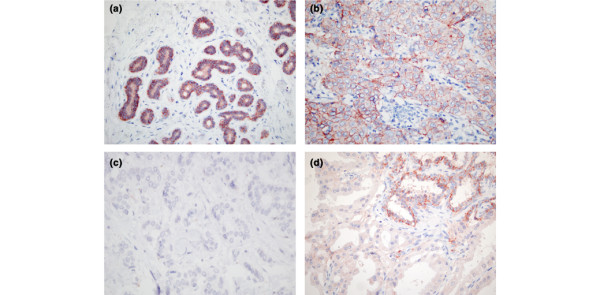
Claudin (CLDN)4 expression in benign breast epithelium, in invasive ductal carcinomas and in intraductal papilloma. (a) Intense CLDN4 positivity in benign breast epithelium. Shown is the immunohistochemical reaction of benign breast using monoclonal CLDN4 antibody (Zymed). Strong positivity is seen in epithelial cell membranes. Sections were counter-stained with Mayer's haemalaun. The chromogen substrate was aminoethylcarbazol. (Original magnification: 400×.) (b) CLDN4 positivity in invasive ductal breast carcinoma. CLDN4 is expressed in invasive ductal breast carcinoma of grade 3. Positive reaction is evident in the membranes of the tumour cells. Sections were counter-stained with Mayer's haemalaun. The chromogen substrate was aminoethylcarbazol. (Original magnification: 600×.) (c) CLDN4 expression in invasive ductal carcinoma of the breast. Shown is complete loss of CLDN4 expression in invasive ductal breast carcinoma of grade 1 as compared with grade 3 (panel b). Sections were counter-stained with Mayer's haemalaun. The chromogen substrate was aminoethylcarbazol. (Original magnification: 400×.) (d) CLDN4 positivity in intraductal papilloma. Shown is the immunohistochemical reaction of breast papilloma with an area of apocrine metaplasia. The loss of CLDN4 positivity in apocrine cells and the positive staining of other epithelial cells is a 'mirror image' of that seen in the CLDN1 reaction (Fig. 2d). Sections were counter-stained with Mayer's haemalaun. The chromogen substrate was aminoethylcarbazol. (Original magnification: 400×.)